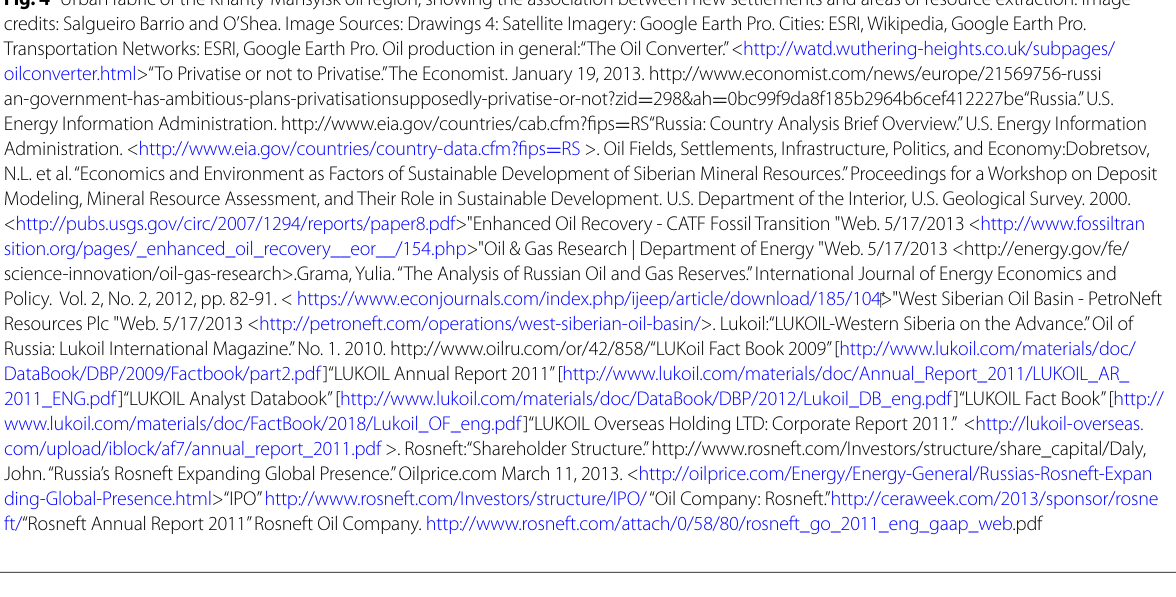
298&ah 0bc99f9da8f185b2964b6cef412227be“Russia.” U.S. = = RS“Russia: Country Analysis Brief Overview.” U.S. Energy Information = RS >. Oil Fields, Settlements, Infrastructure, Politics, and =